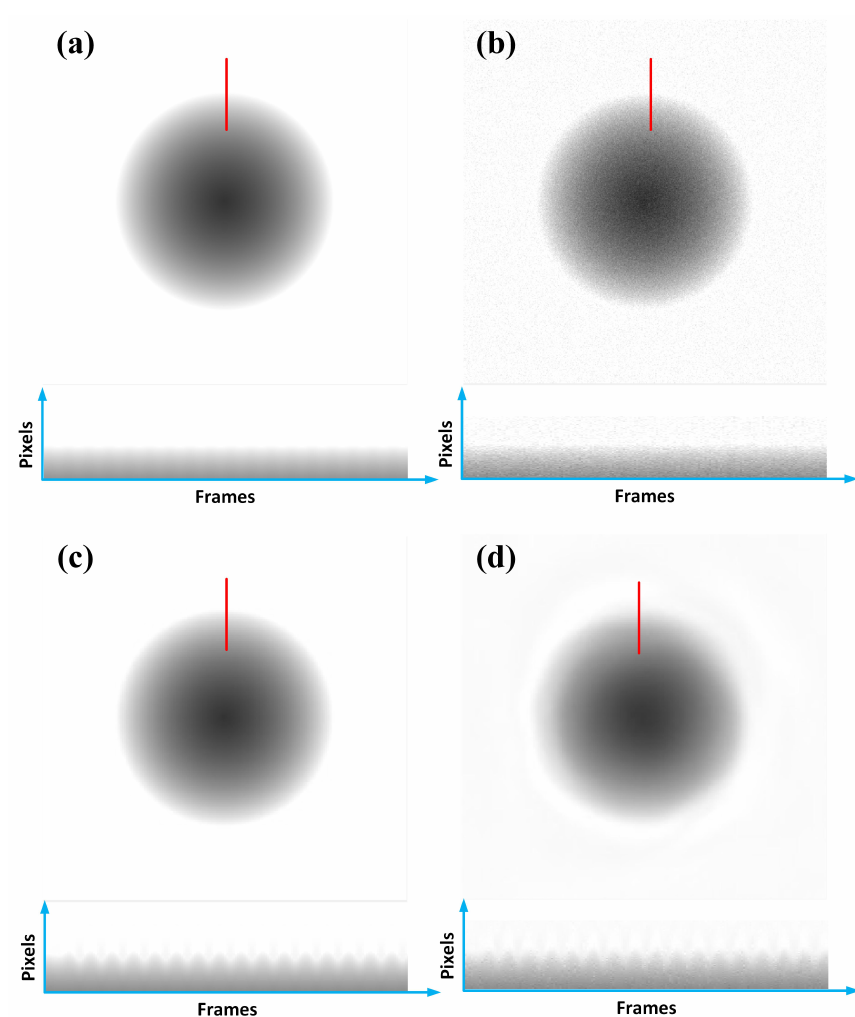
Figure 3. The black circle simulation test: ( a ) original clean video frame and pixel time slice; ( b ) noise video frame with Gaussian white noise of variance 0.005 and pixel time slice; ( c ) magnified clean video frame and pixel time slice; ( d ) magnified noise video frame and pixel time